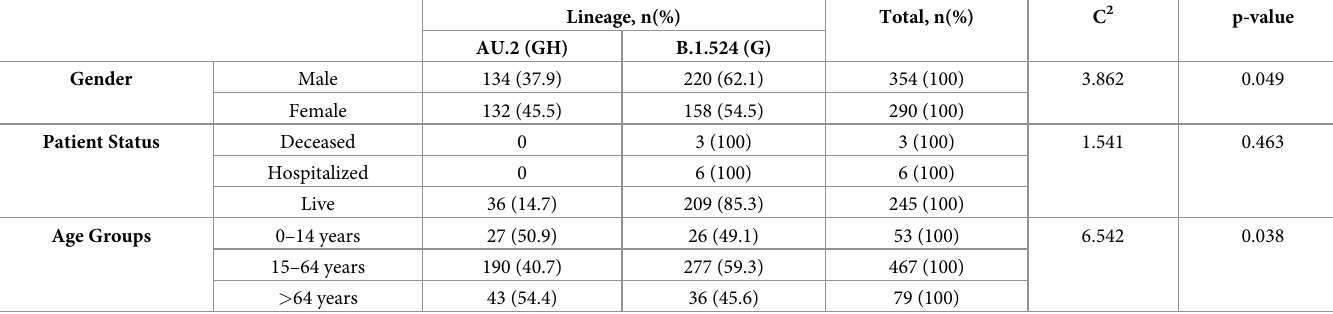
Table 1. The distribution of the lineages between gender, patient status and age